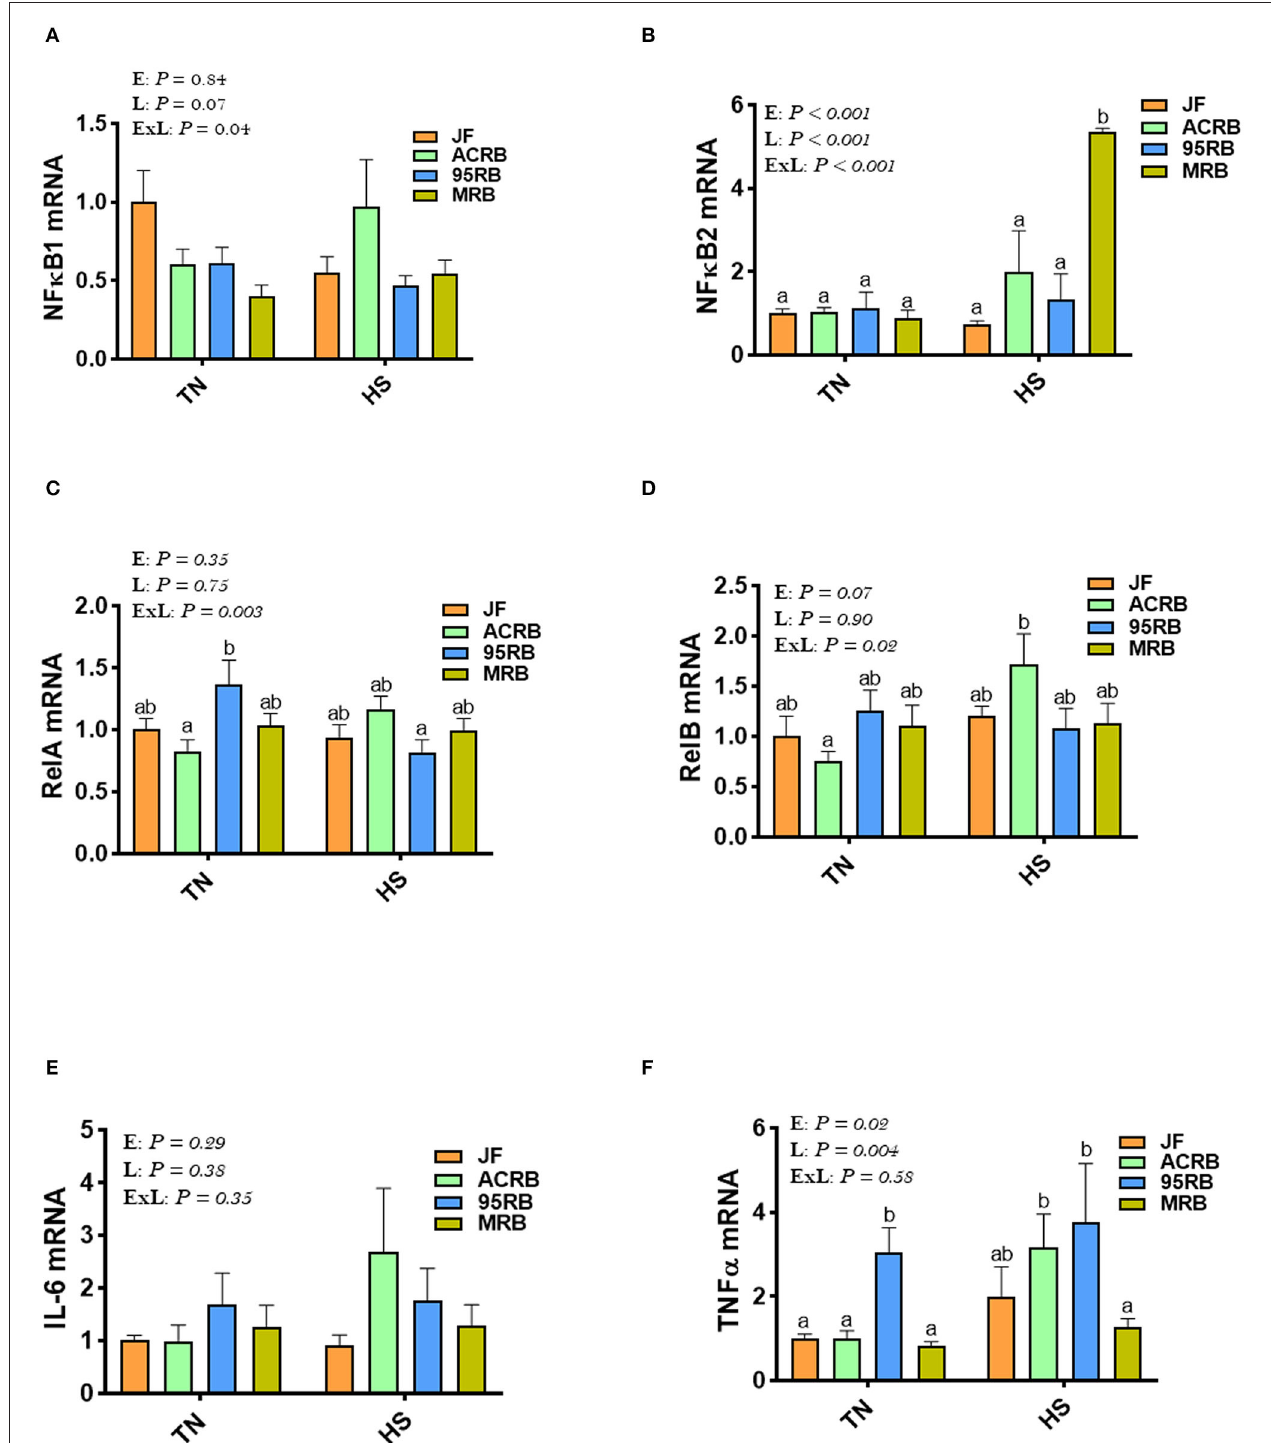
FIGURE 5 | Effect of HS on hypothalamic expression of NF- κ B pathway, TNF α , and IL-6 in three modern broilers and their ancestor JF. RNA was extracted from hypothalamic tissues and analyzed by qPCR using 2 − 11 CT method. Data for gene expression of NF- κ B1 (A) , NF- κ B2 (B) , RelA (C) , RelB (D) , IL-6 (E) , and TNF α (F) are mean ± SEM ( n = 6/group). Different letters indicate significant difference at P < 0.05. 95RAN, 1995 random bred; ACRB, Athens Canadian Random Bred; E, environment; ExL, interaction between E and L; HS, heat stress (36 ◦ C); IL-6, interleukin 6; JF, jungle fowl; L, line; MRB, modern random bred; NF- κ B, Nuclear Factor Kappa B; RelA/B, v-rel avian reticuloendotheliosis viral oncogene homolog A/B; TN, thermoneutral (25 ◦ C); TNF α , tumor necrosis